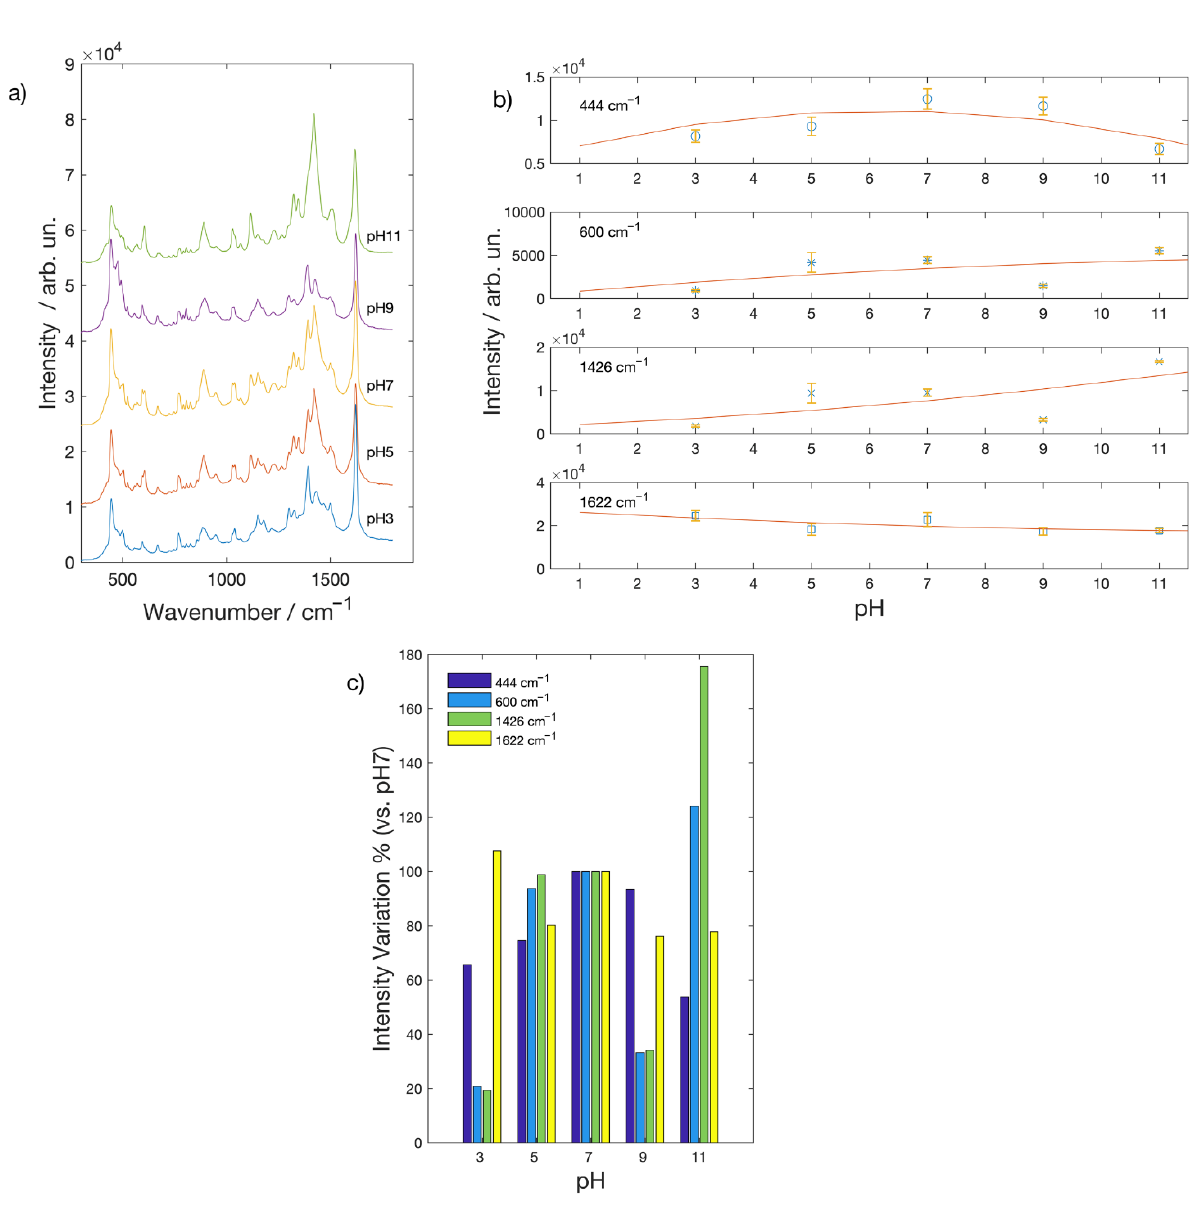
Figure 3. ( a ) SERS spectra of a MB 2.5 × 10 − 4 M solution at different pH values acquired on Au SERS active substrates; ( b ) intensity behavior of some MB Raman peaks as function of the pH (lines are a guide for the eye); ( c ) intensity variation of Raman peaks in % with respect to the value at pH = 7.